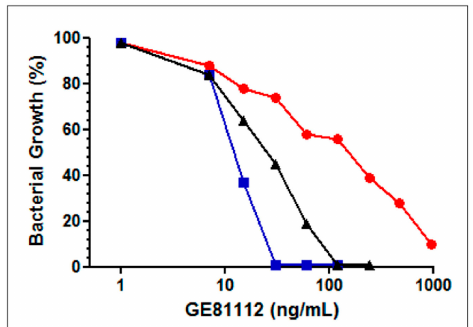
Figure 4. Effect of tri- L -alanine and L -leucine on the antibacterial activity of GE81112. Effect of the GE81112 concentrations indicated in the abscissa on the growth in David Mingioli minimal medium of E. coli MG1655 in the absence of other additions (black triangles), in the presence of 25 µ g/mL tri- L -alanine (red circles), of 100 µ g/mL L-leucine (blue squares). The microtiter wells were filled with 100 µ L medium inoculated with 10 4 cfu/mL and the bacterial growth determined from the A 620 attained after 24 h at 37 °C.